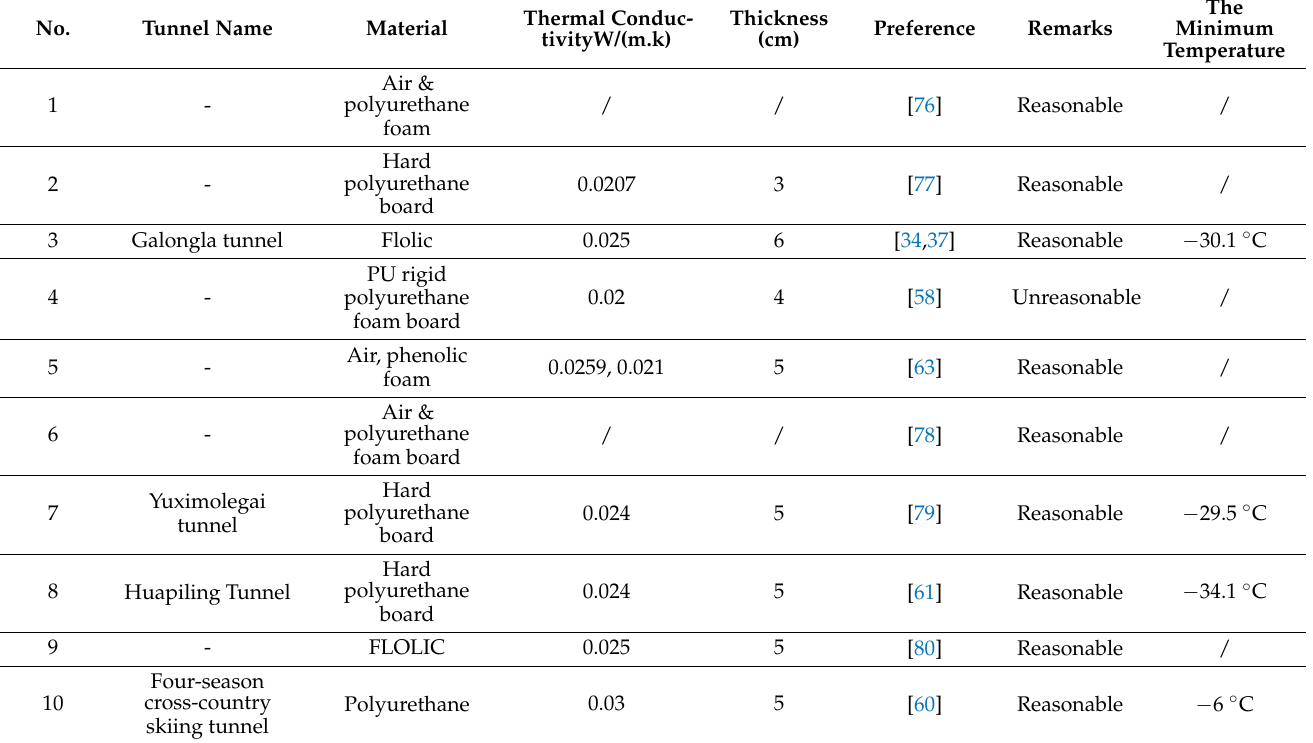
Table 8. Thickness of the insulation layer used in some